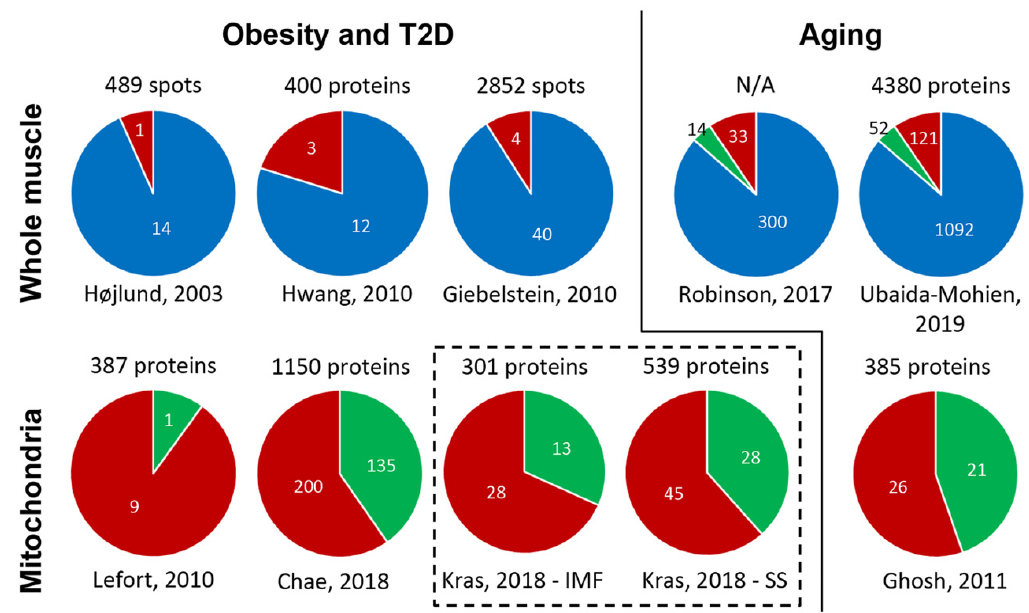
Figure 3. Altered mitochondrial proteome in skeletal muscle in obesity, T2D, and aging. The pie charts show the total number of protein spots or proteins quantified in whole muscle or the total number of mitochondrial proteins quantified in isolated mitochondria (top), and the number of regulated non-mitochondrial (blue) proteins and downregulated (red) or upregulated (green) mitochondrial proteins identified in relation to obesity, T2D, or aging in proteomic studies of human skeletal muscle (whole muscle or isolated mitochondria) published (first author, year of publication). The pie charts in the box with dotted lines represent a study of both intermyofibrillar (IMF) and subsarcolemmal (SS) muscle mitochondria. N/A, not available.